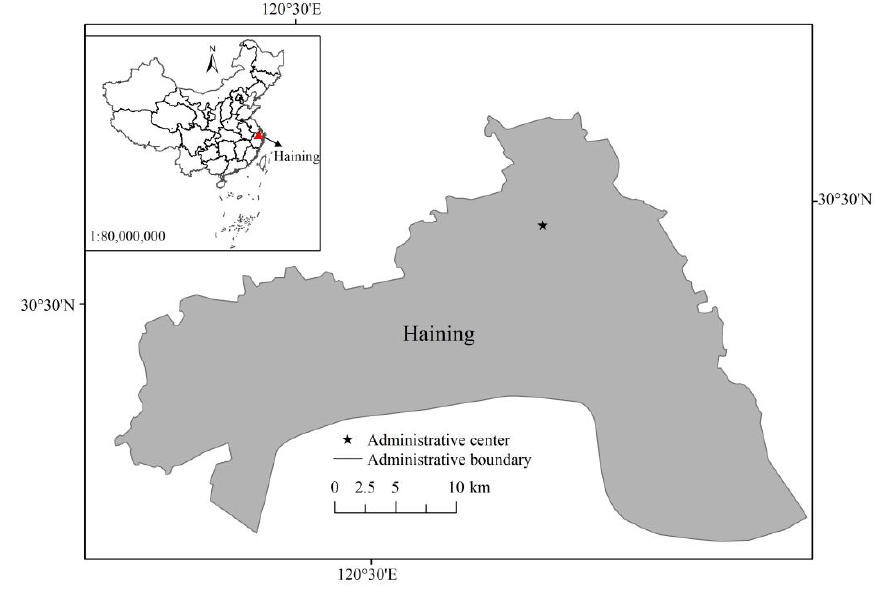
Figure 1. Location of Haining in China.